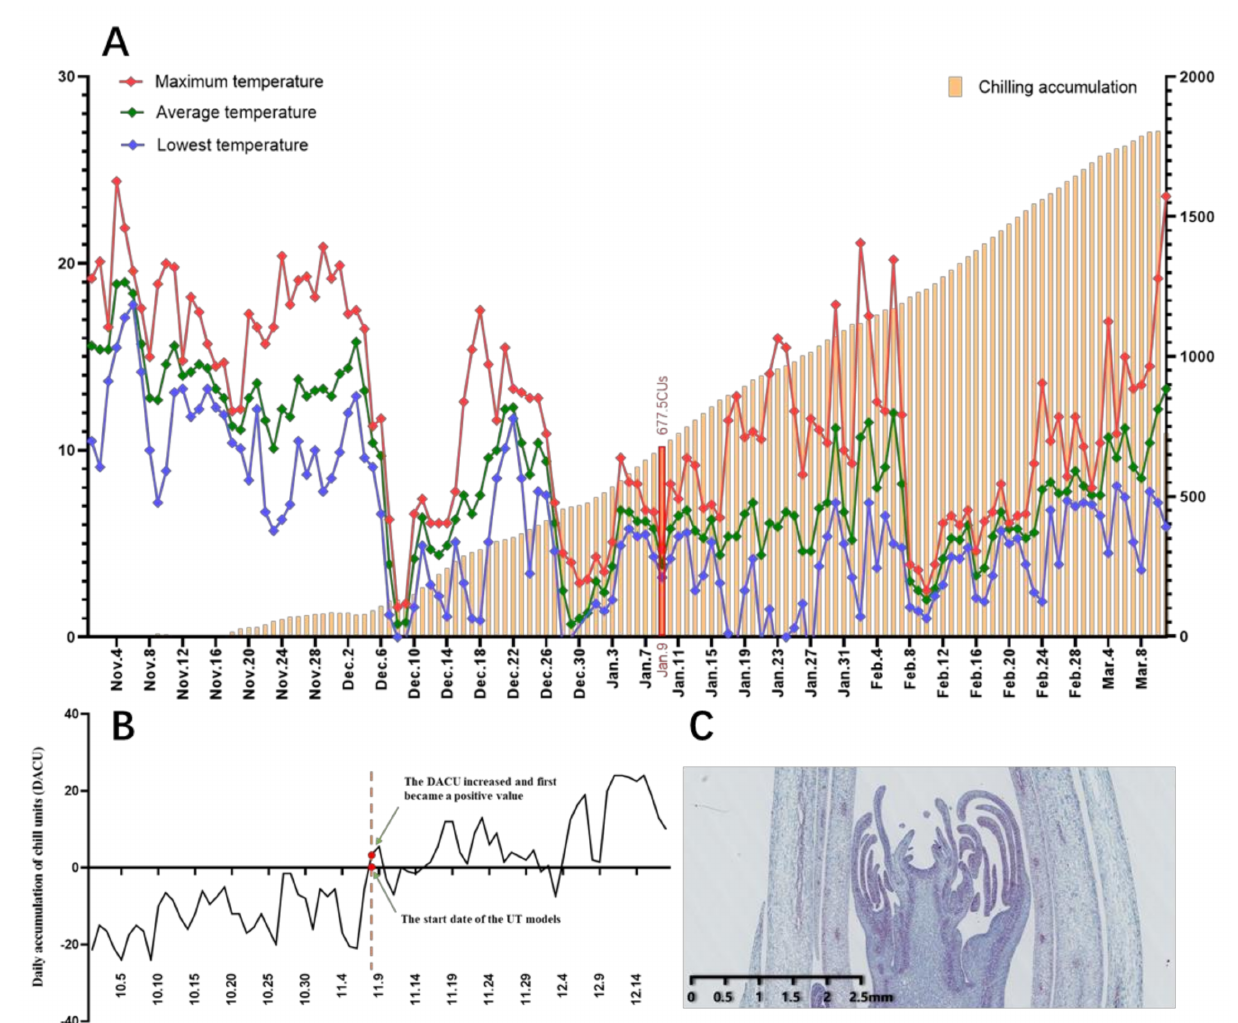
Figure 2. ( A ): Temperature change and chilling accumulation of underground buds from ‘Meiju’ during dormancy (using the UT model to calculate the chilling accumulation). The line chart represents the daytime temperature, and the bar chart represents the chilling accumulation value. ( B ): Trends in the daily chill-unit accumulation and start dates for CR evaluations via the UT model. ( C ): A slice of the underground bud closest to the start